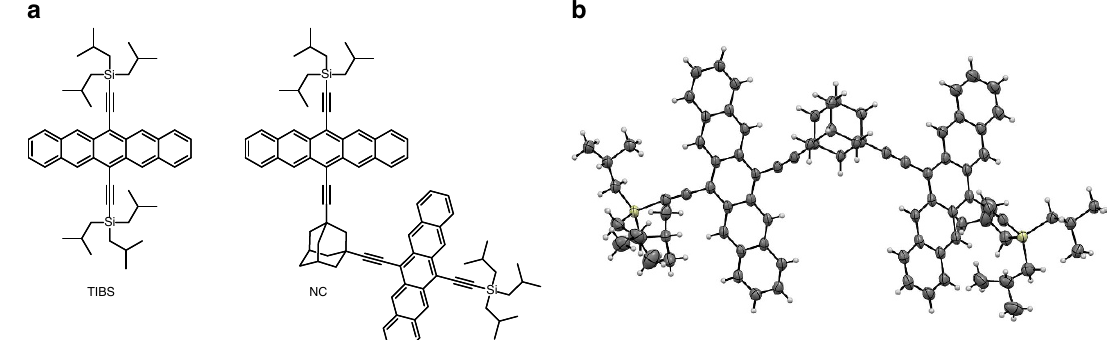
Figure 1 | Molecular and solid-state structures. ( a ) Chemical structures of the pentacene monomer (TIBS) and dimer (NC). ( b ) X-ray crystallographic structure of NC illustrating the arrangement and proximity of the two